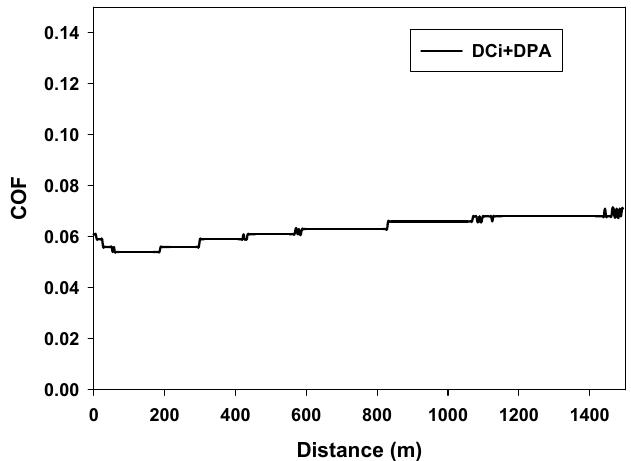
Figure 4. Typical coefficient of friction vs distance record.